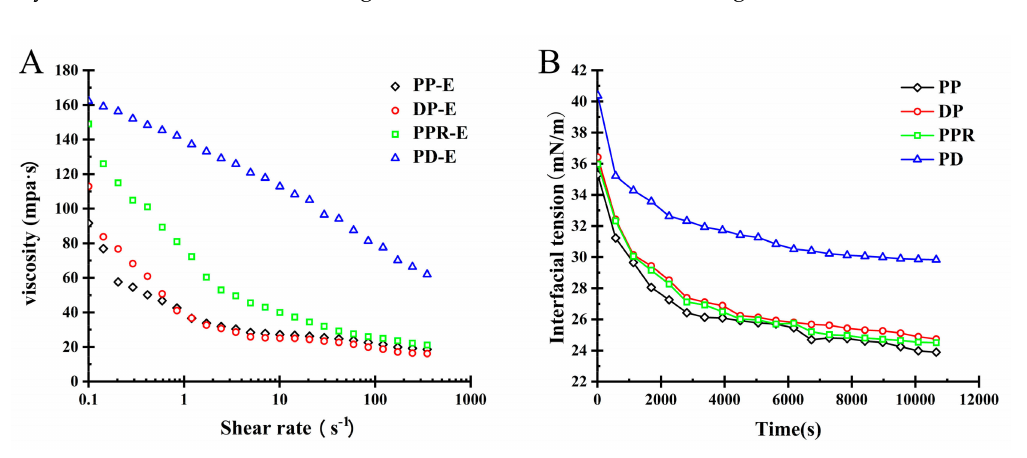
Figure 6. Viscosity of PP emulsion with di ff erent purification treatments as a function of shear rate ( A ), adsorption curve of PP at oil-water interface for di ff erent purification treatments ( B ) (25 ◦